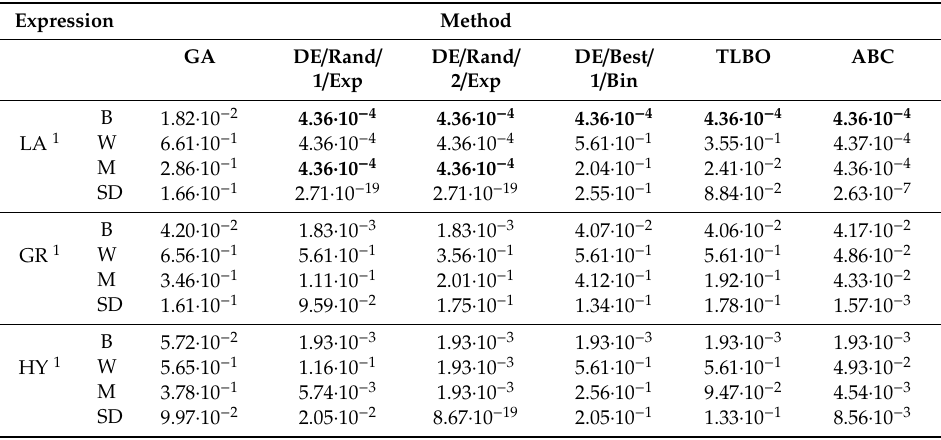
Table 3. B, W, M and SD for 30 independent runs of di ff erent methods using expressions (1) to (7) for left part of the Alnico measured major hysteresis loop